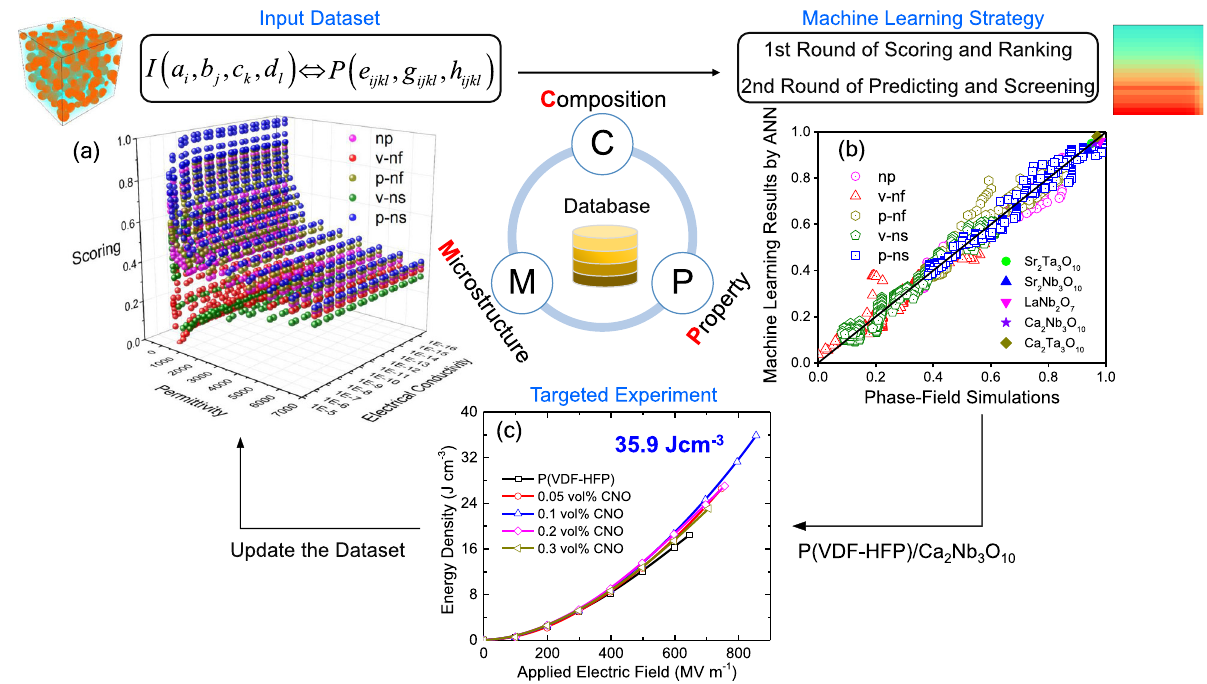
Fig. 5 The simulation-guided material development paradigm from theoretical predictions to targeted experiments. a The input data set of scoring of different polymer nanocomposites. b Comparisons of scoring between the phase- fi eld simulations and machine learning results, and fi ve 2D perovskite nano fi llers are evaluated as marked by color solid symbols. c The discharged energy density of P(VDF-HFP))/ Ca 2 Nb 3 O 10 (CNO) nanocomposites with different volume fractions at different applied electric fi